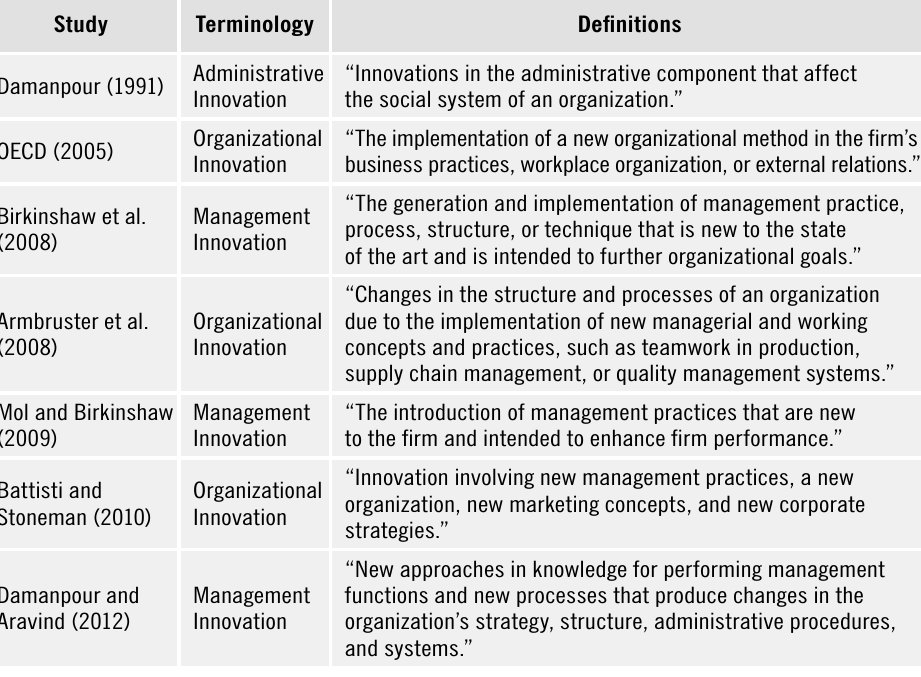
Table 1. Definitions of management